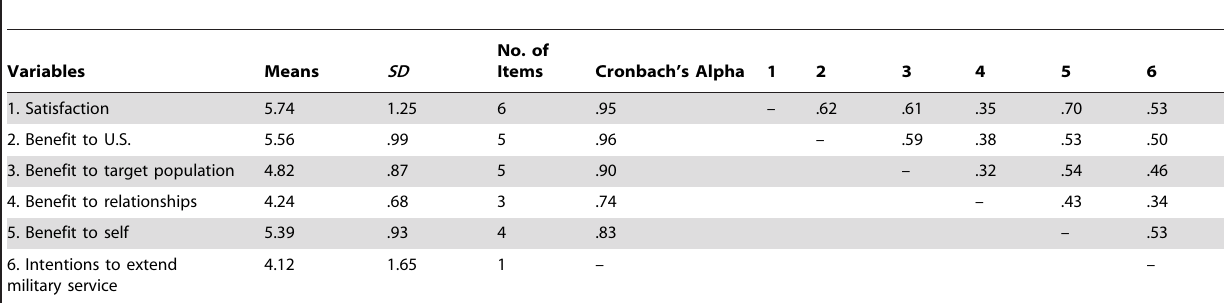
Table 3. Descriptive statistics, Cronbach’s alphas, and Pearson correlations between the five survey variables and participants’ intentions to extend their military service beyond their current